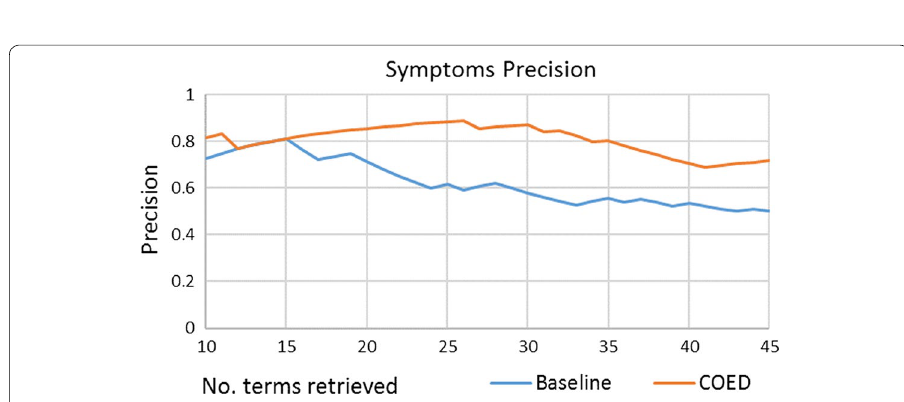
Fig. 10 Comparison of symptoms precision for baseline and COED